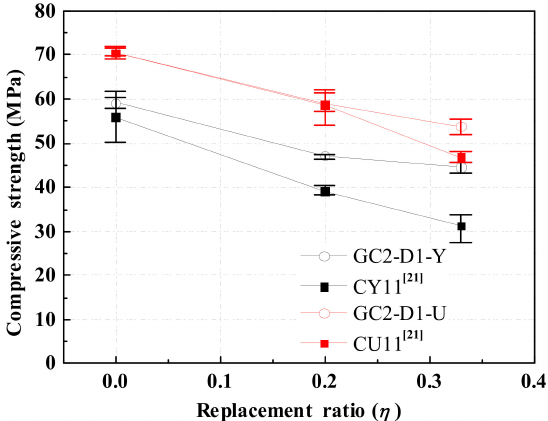
Figure 8. Comparison on compressive strength of GRLC specimens in this study and cement recycled lump concrete (CRLC) specimens in Ref.